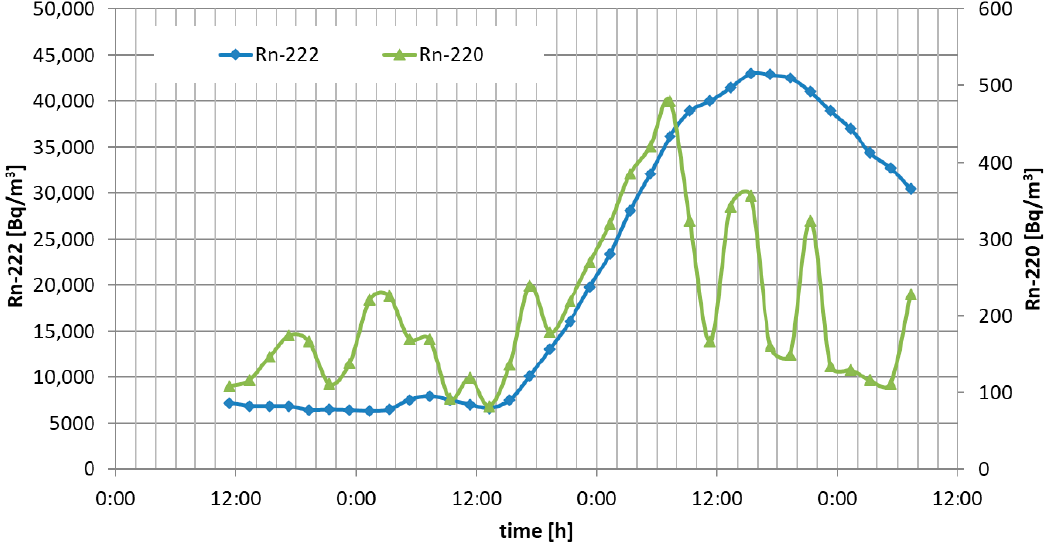
Figure 4. Results of radon (orange) and thoron (green) concentration in the gallery—1st campaign.